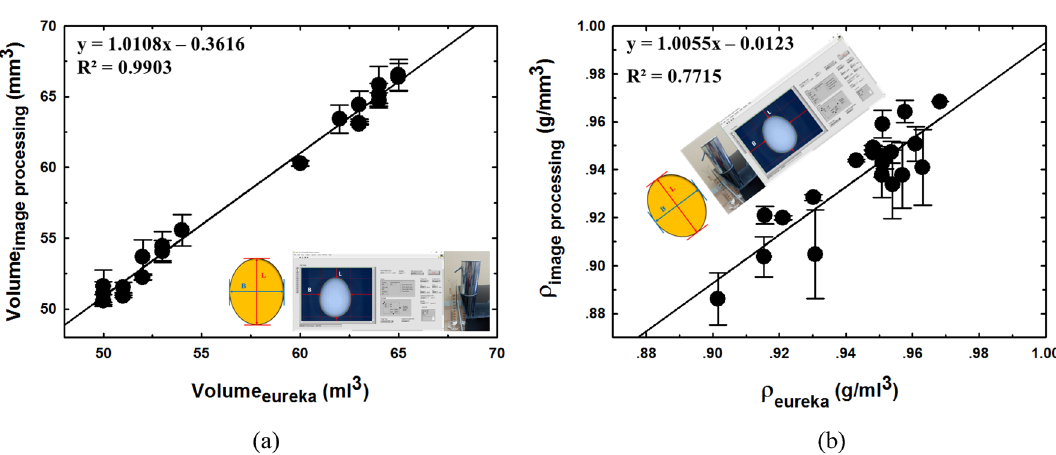
Figure 6. Measurement of volume and density of egg ( a ) volume and ( b )